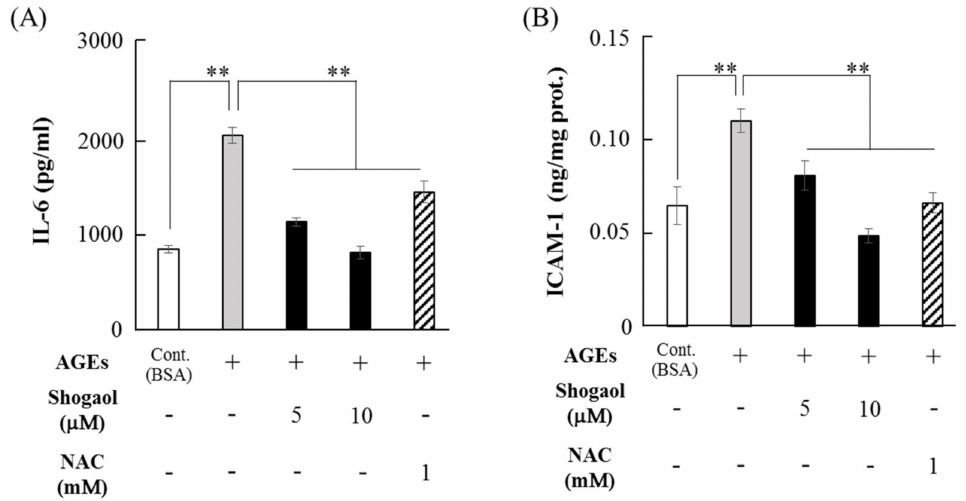
Figure 5. E ff ects of 6-shogaol on AGEs-induced production of IL-6 and ICAM-1. Sub-confluent HGFs were pre-treated with 6-shogaol (5 or 10 µ M) for 1 h and cultured with AGEs (500 µ g / mL) or BSA (500 µ g / mL) for 48 h. NAC (1 mM) was also added into the HGF culture with AGEs. The amounts of IL-6 ( A ) in the supernatant and ICAM-1 ( B ) in the cell lysate were determined using their respective ELISA kits as described in the Materials and Methods section. Data are expressed as the mean ± SD of 6 independent experiments (** p <